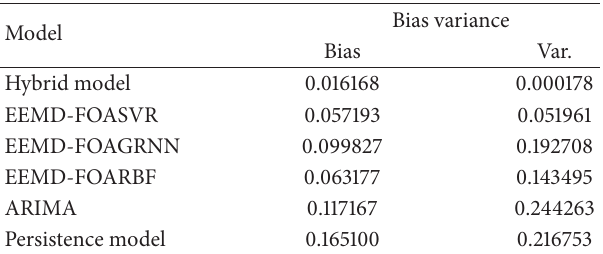
Table 9: Bias-variance test of seven models for the mean value in four